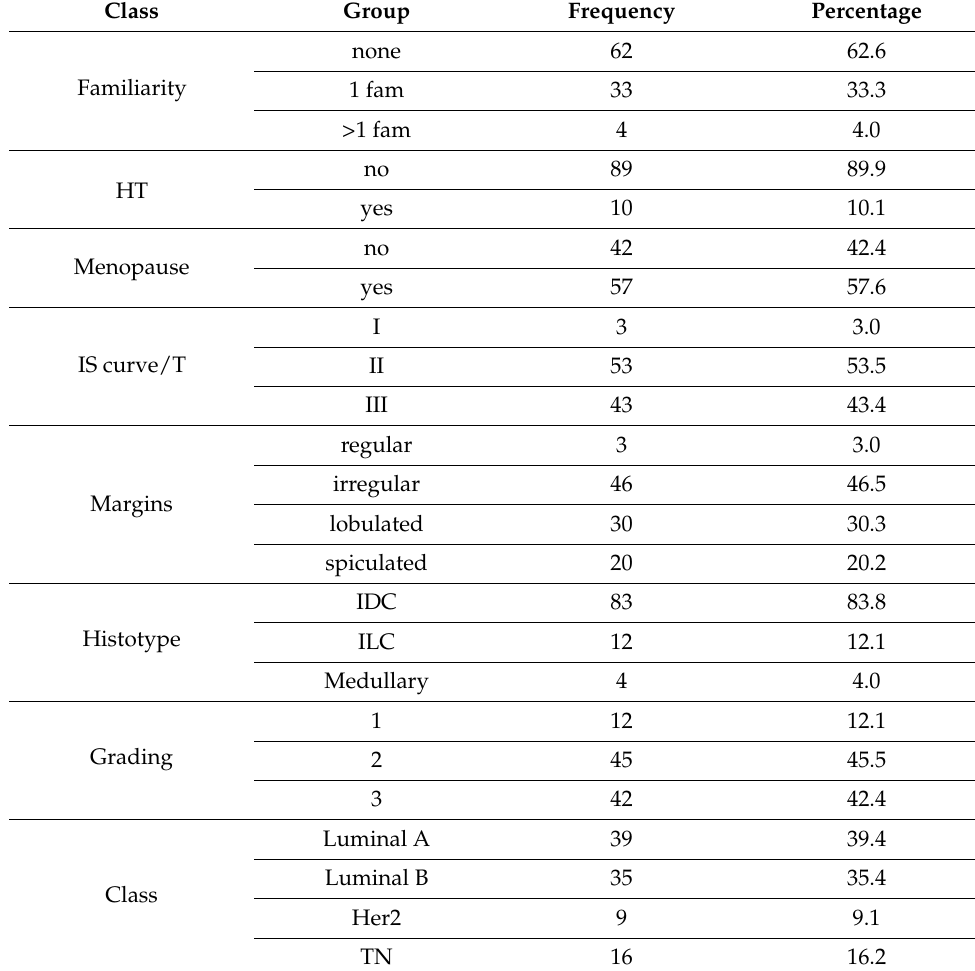
Table 3. Main frequencies for the various semantic classes analyzed.